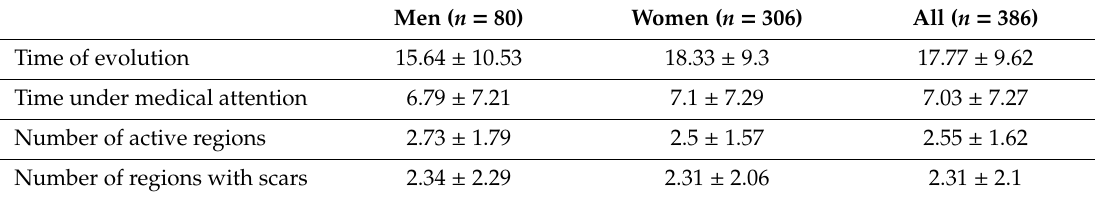
Table 2. Hidradenitis suppurativa (HS) patients’ baseline